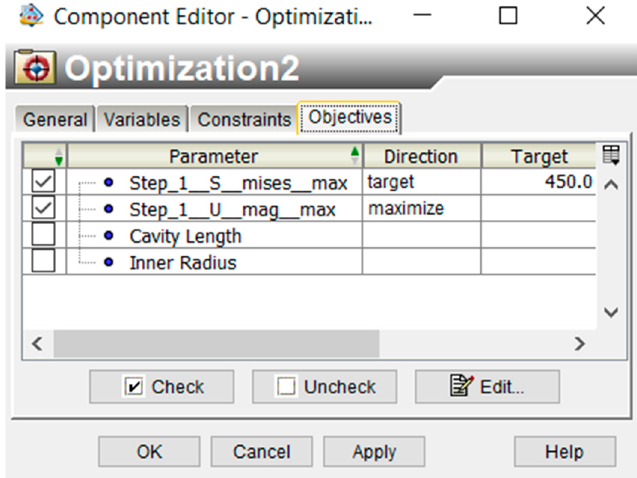
Figure 12. Objective selection.